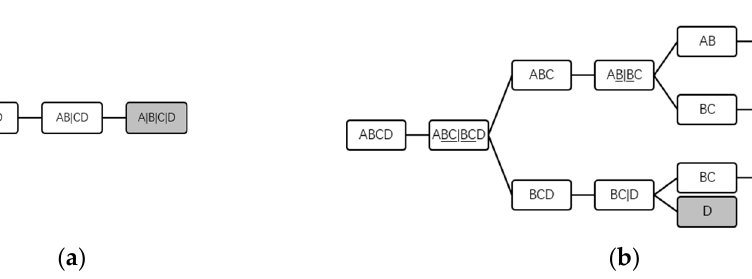
Figure 3. Two kinds of tree-like structures for the distillation sequence representation are listed as: ( a ) A completed sharp distillation sequence tree (line structure) and ( b ) A completed nonsharp distillation sequence hybrid multiway tree.